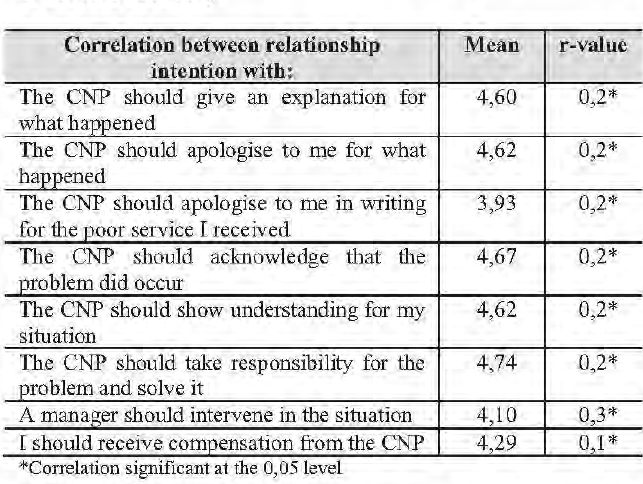
Table 4: Relationship intention and action expectations of service recovery